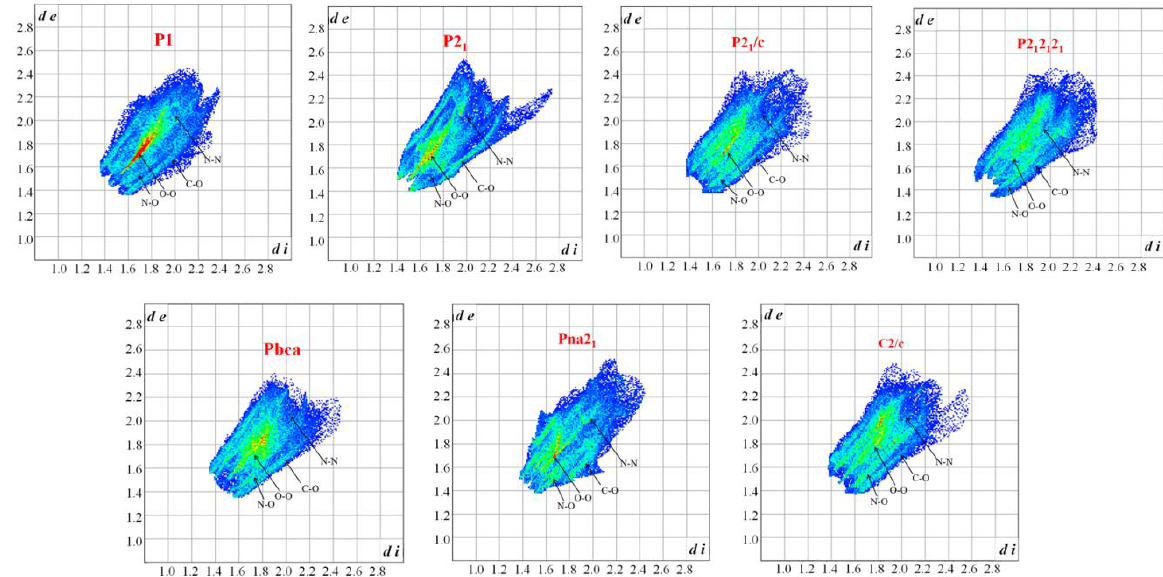
Figure 5. Two-dimensional fingerprint plots in crystal stacking.